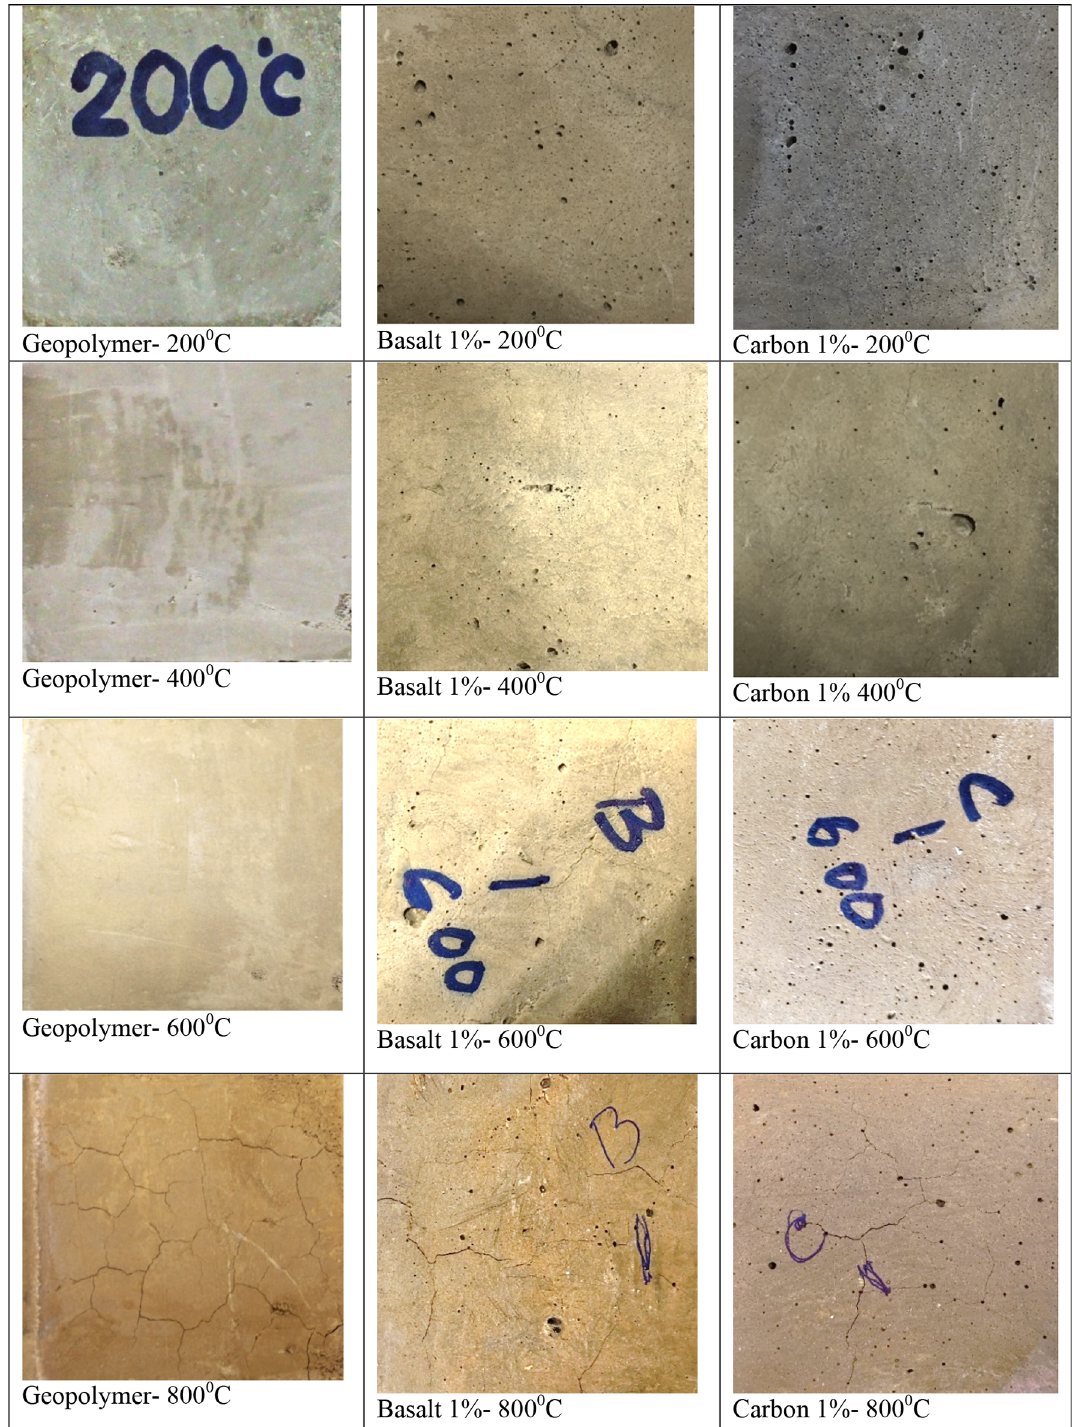
Fig. 5 Cracking behaviour of pure geopolymer and geopolymer composite containing 1 wt% of carbon and basalt fibres at various elevated